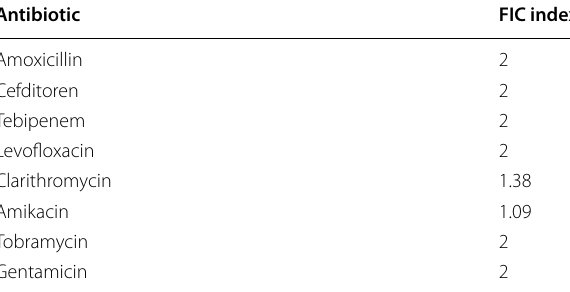
Table 3 Combined antimicrobial effect (FIC index) of the Natto peptide and other antimicrobial agents